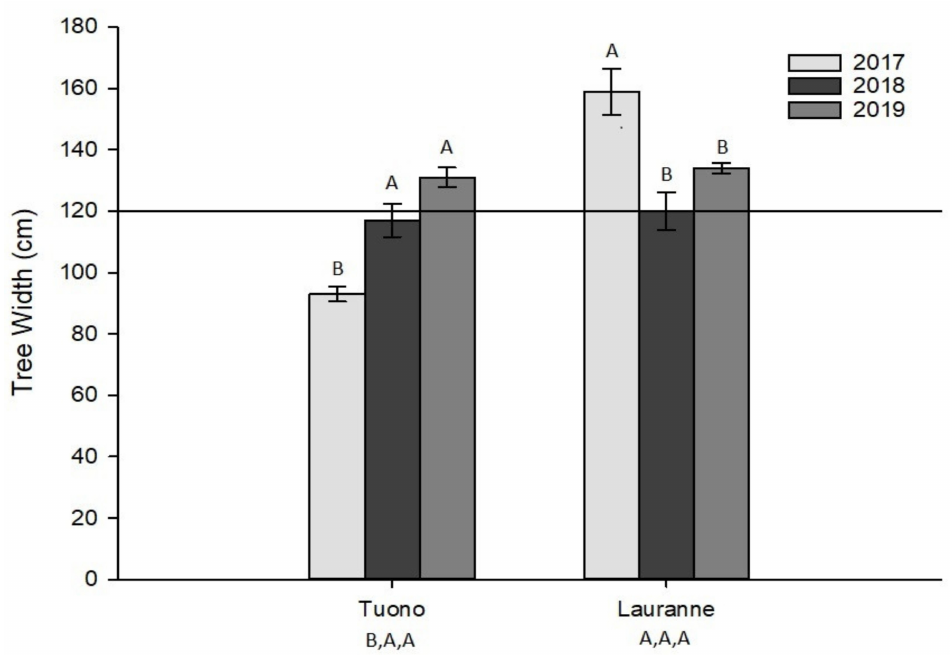
Figure 6. Tree Width of cultivars Tuono and Lauranne in three subsequent years (2017–2019). The letters on the bars denote statistical differences among the years for each cultivar; the letters on the x-axis denote statistical differences between cultivars for each year (SNK test). Letters denote statistical differences at p = 0.01. The threshold values are also